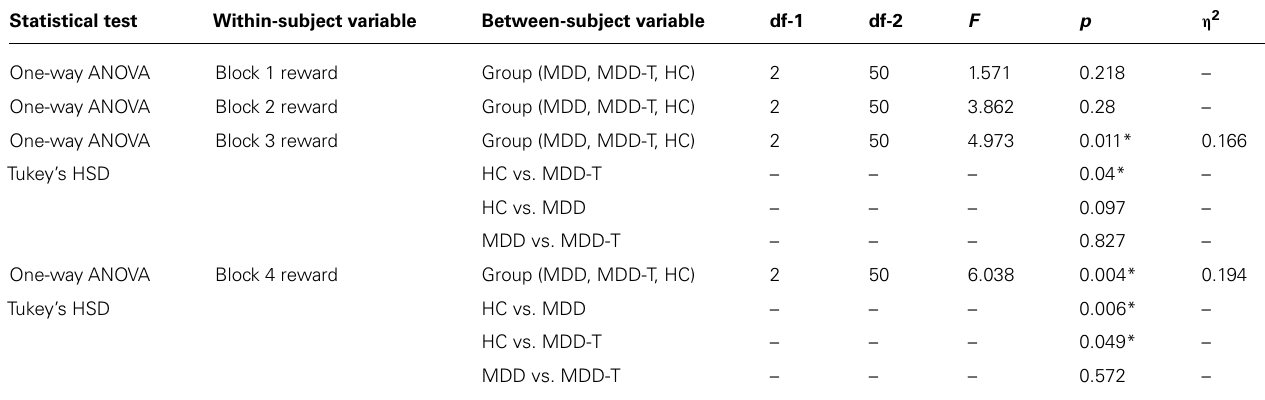
Table 2 | Summary of the post hoc one-wayANOVA andTukey’s HSD post hoc results to explore the significant interaction between group and block in reward learning, with group as the between-subject variable, and the percentage of correct responses on a each one of the four reward learning block was the within-subject variable, with a Bonferroni correction adjusted α = 0.0125 to protect the level of